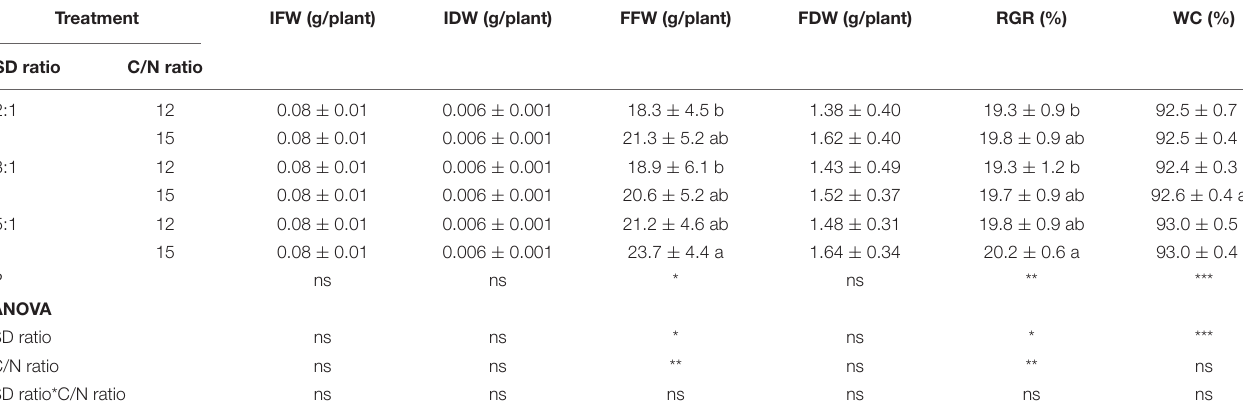
TABLE 4 | Initial fresh weight (IFW), initial dry weight (IDW), final fresh weight (FFW), final dry weight (FDW), relative growth rate (RGR), and water content (WC) of minutina cultivated in marine aquaponics at three stocking density ratios (SD ratio) of shrimp to plant and two C/N ratios for 4